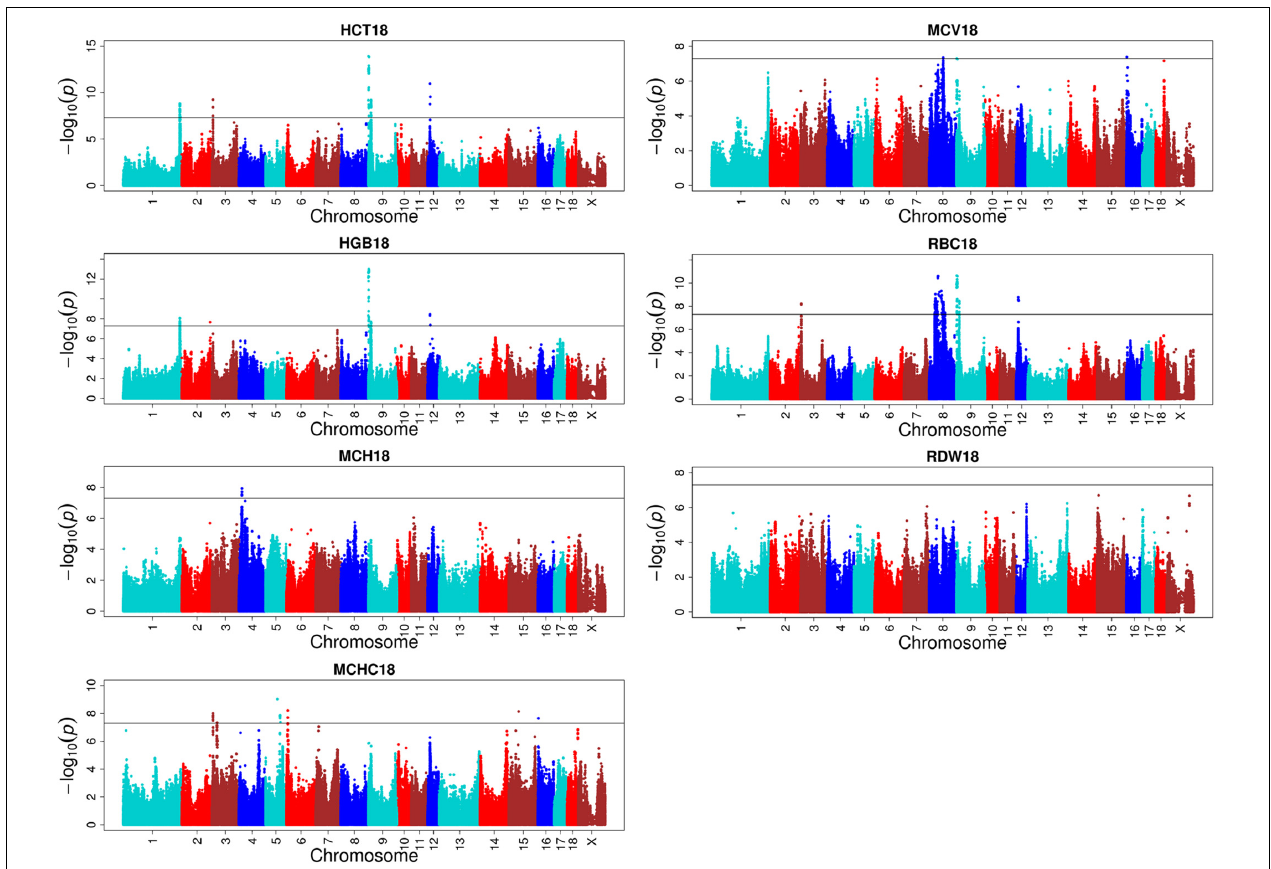
FIGURE 3 | Single-marker GWAS results for seven erythrocyte traits at day 18. The y -axis and the x -axis represent the negative log 10 P-value of the SNPs and the genomic positions separated by chromosomes, respectively, and the black solid lines indicate the significance threshold (negative log 10 5E-08).